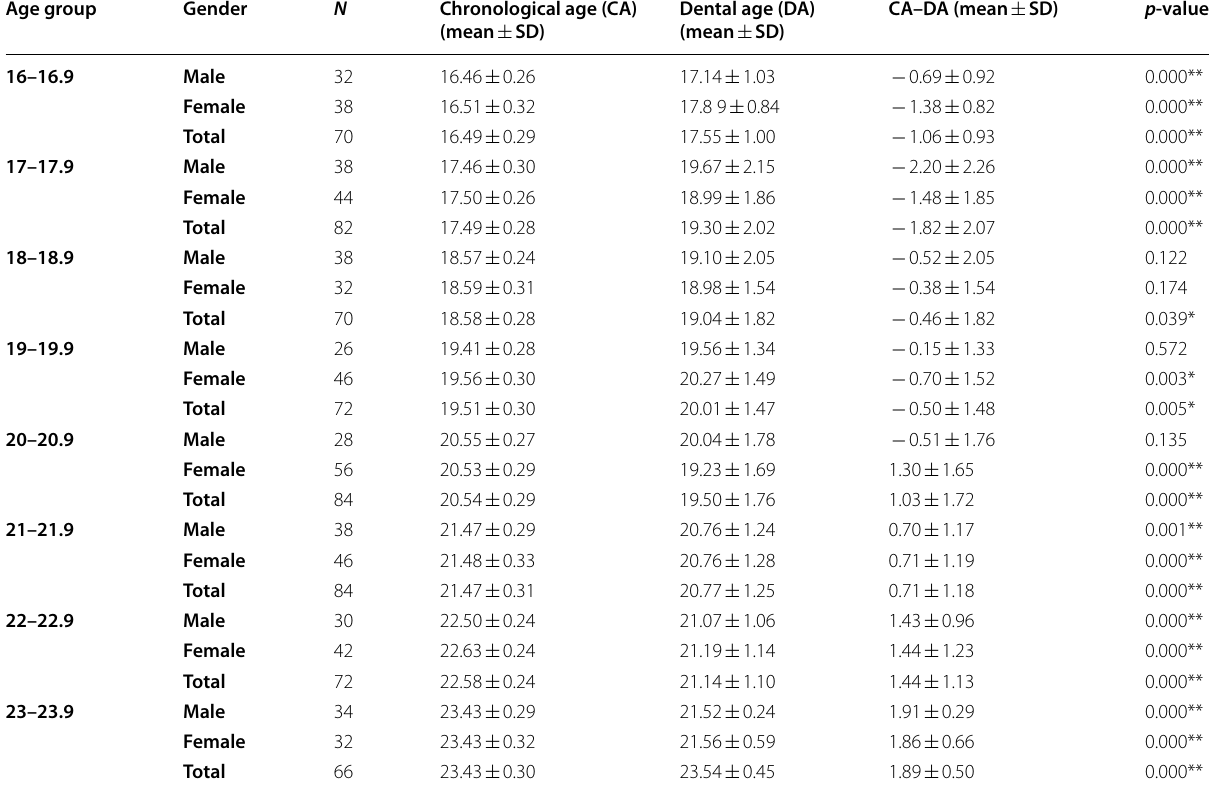
Table 1 The paired t -test was used to compare the differences between the chronological age and the dental age calculated using the modified Cameriere technique (SB Balla formula adaption) *Denotes statistically significant differences ( p denotes highly statistically significant differences ( p ≤